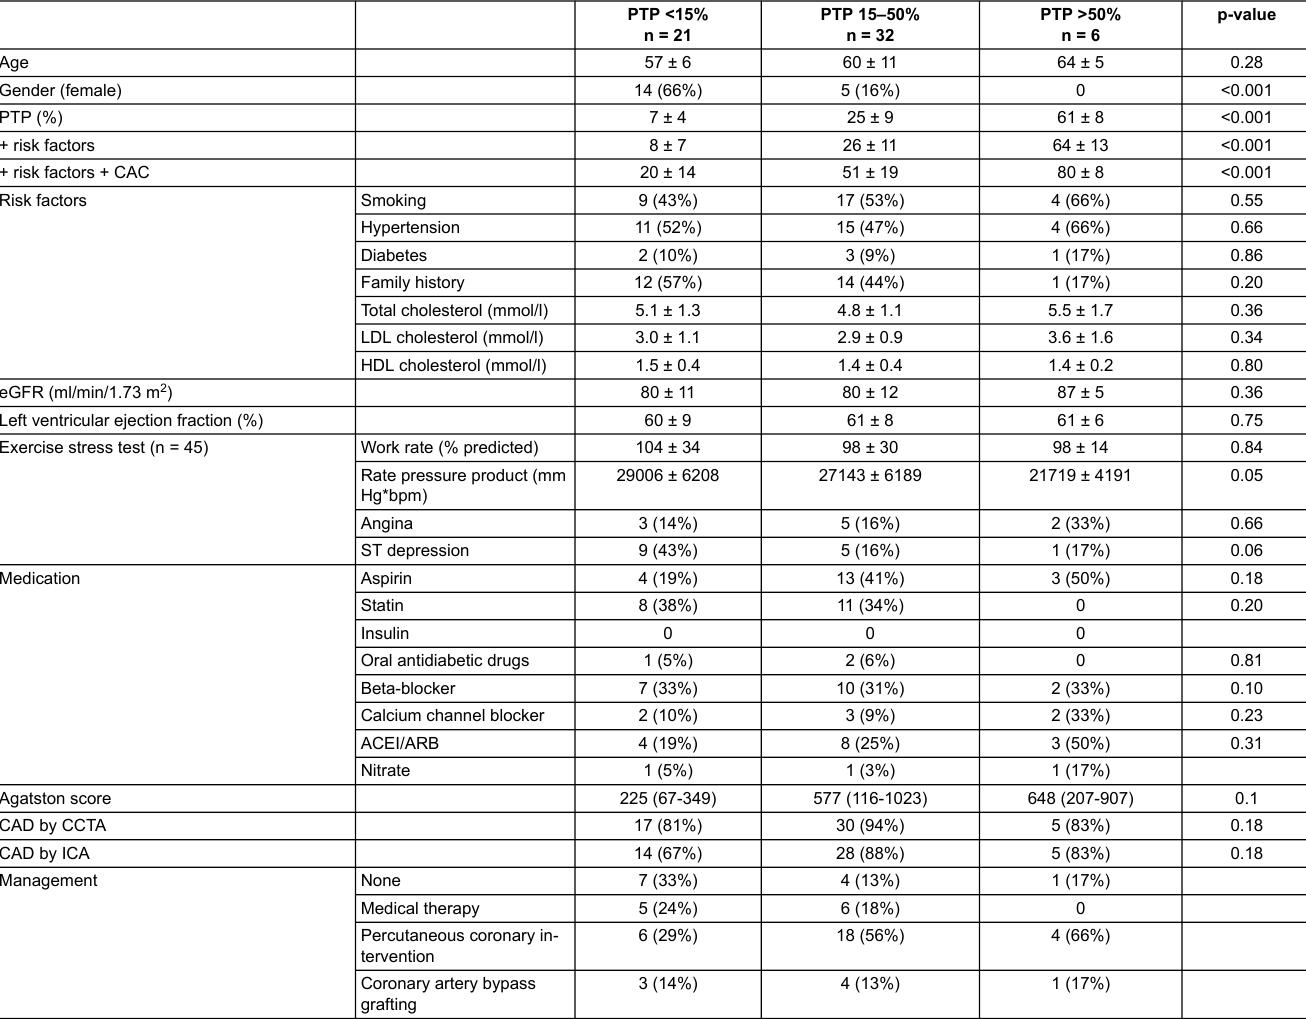
Table 2: Characteristics of the subgroup of patients undergoing both coronary computed tomography angiography (CCTA) and invasive coronary angiography (ICA; n = 59) ac- cording to the three pretest probability (PTP)